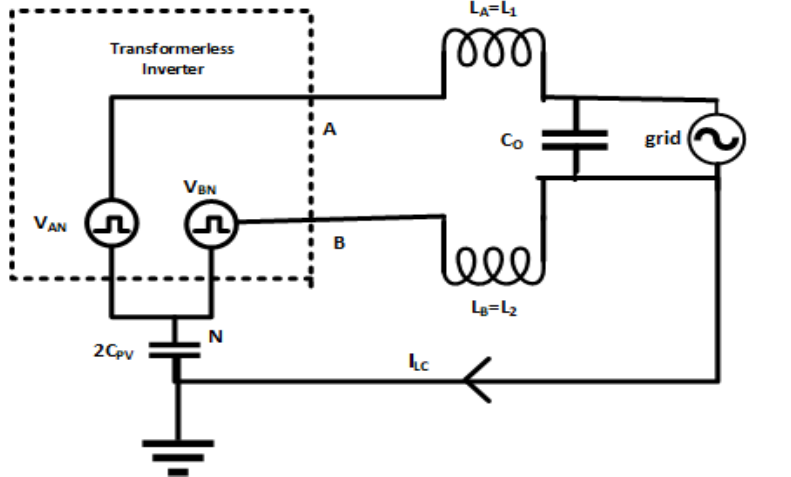
Figure 4. Simplified common mode model of single-phase grid-connected PV with transformerless inverter.